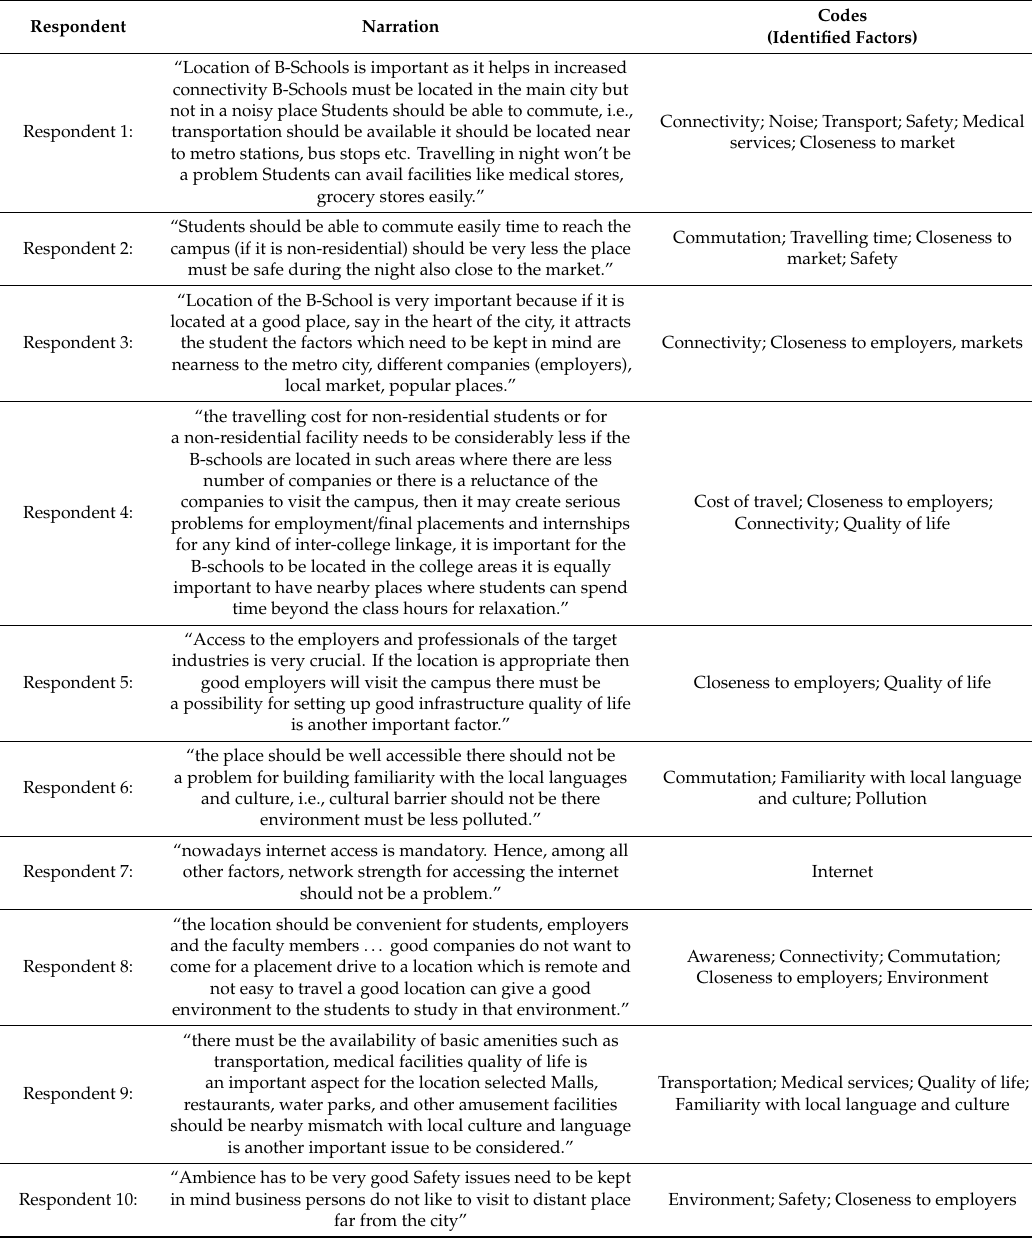
Table 2. Summary of respondents’ opinions and identified